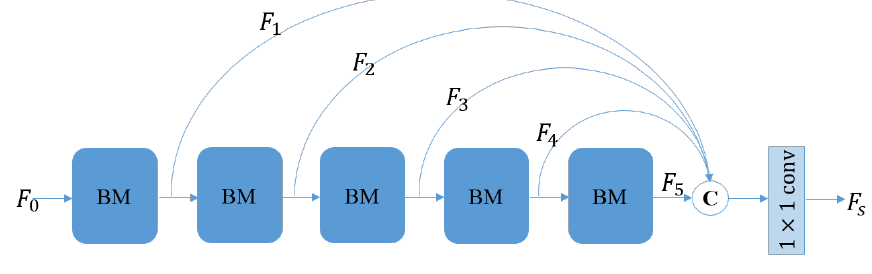
Figure 6. Feature aggregation